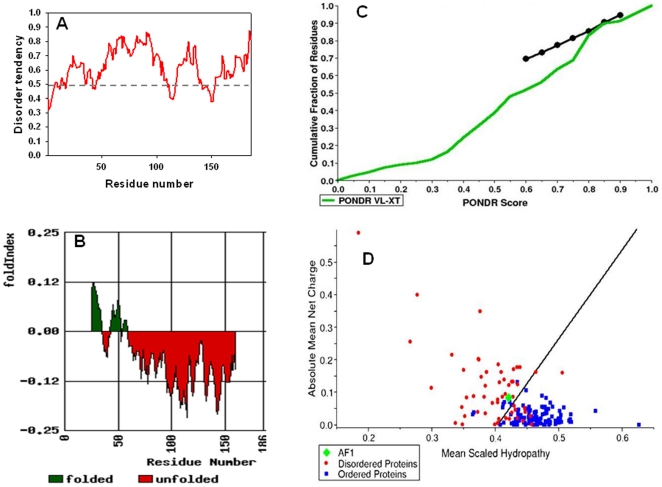
The GR AF1 domain possesses the characteristics of an ID protein.
A) IUPred plot for AF1 protein disorder prediction [38]. Score above 0.5 are considered to be disordered sequences. B) Fold Index showing the probability of AF1 sequences for the propensity to fold [37]. C) Cumulative fraction of AF1 residues showing ID PONDR score of AF1 [36]. D) Charge-hydropathy analysis using Uversky plot [35], [36]. The plot of the mean hydrophobicity vs. mean net charge of 54 completely disordered proteins (red), and 105 completely ordered proteins (blue). The solid line represents the border between ordered and disordered proteins. The cyan square corresponds to AF1.